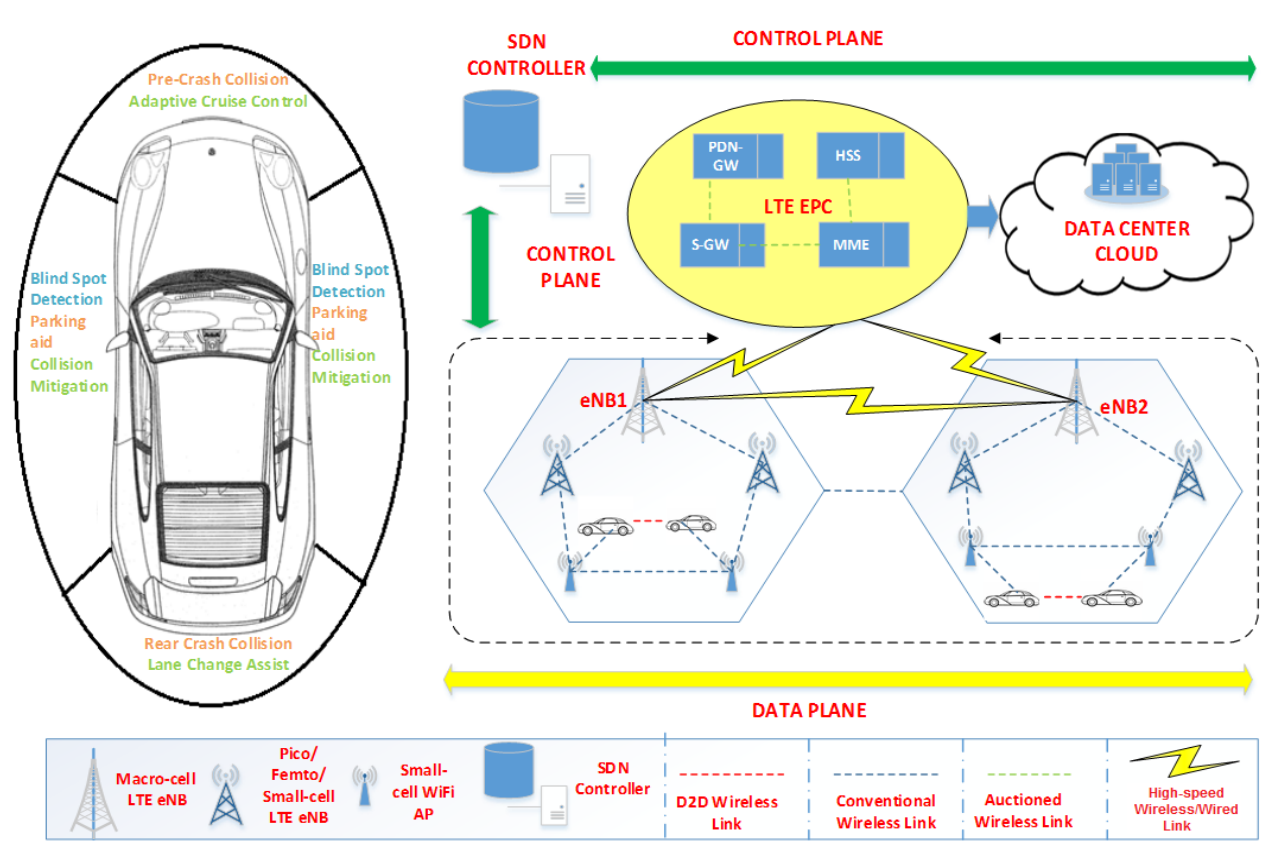
Figure 2. Proposed Architecture for